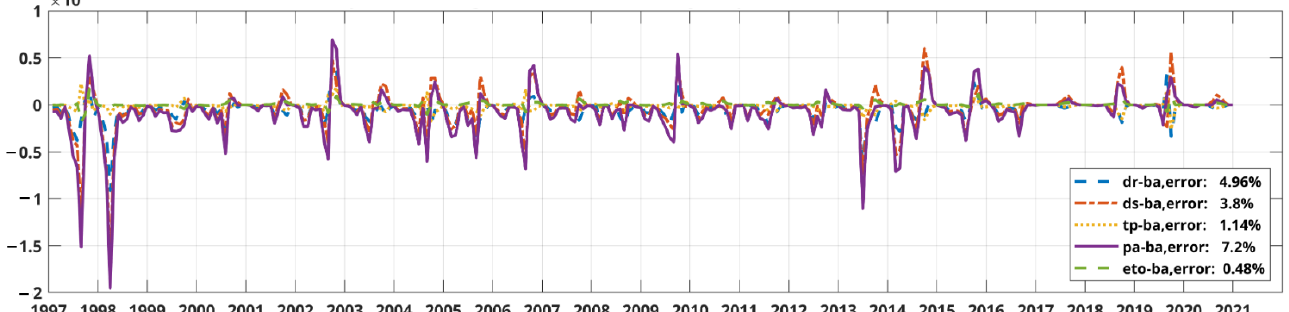
Figure 2. Difference between raw data and joint temporal pattern of burned area. The best separation of the spatial pattern value was obtained from the ds indicator where most of the carbon emissions in the range of 3000–5000 g C m − 2 occurred on the ds area with a severity value of more than 0.4, except on Loc 7 (Figure 3). On Loc 1–5,